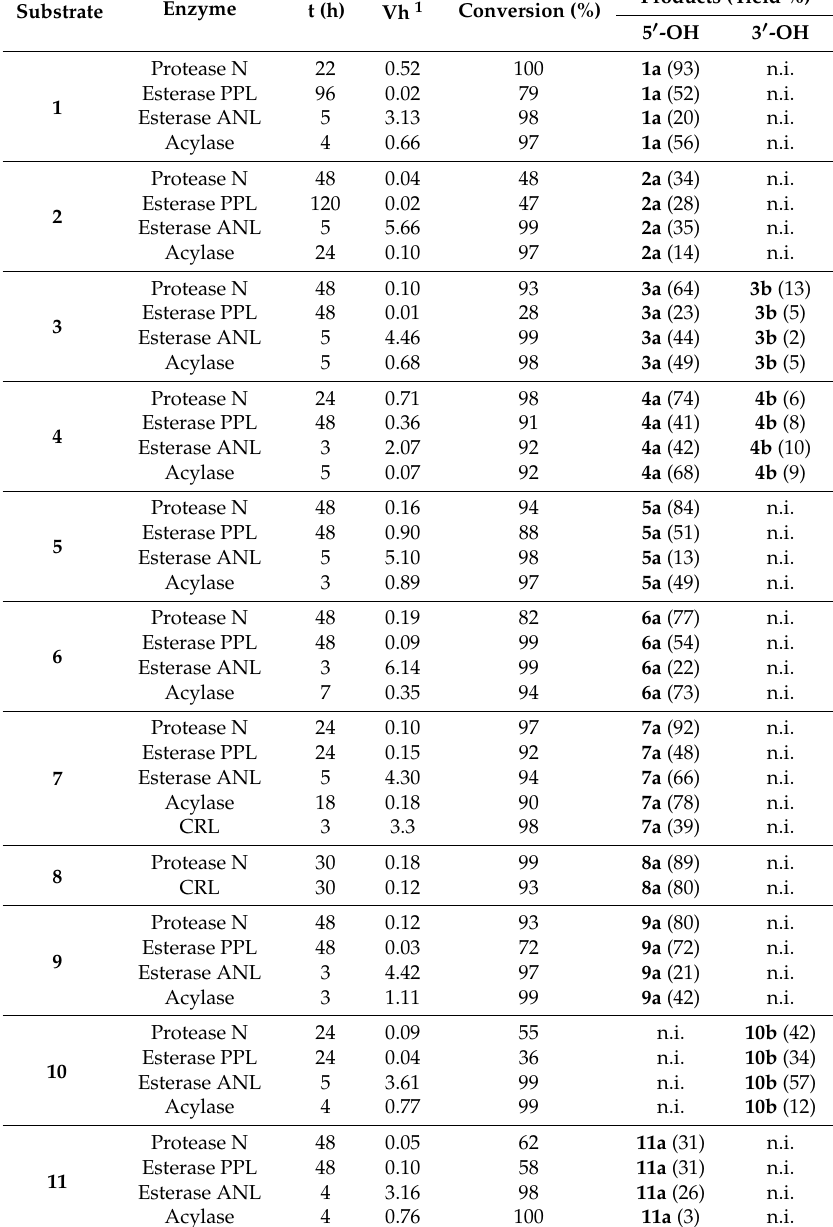
Table 1. Enzymatic hydrolysis of peracetylated pyrimidine nucleosides 1 – 11